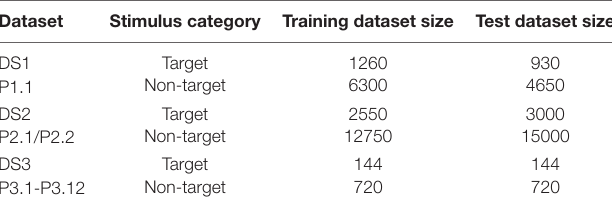
TABLE 1 | The stimulus numbers for each participant of DS1, DS2, and DS3.